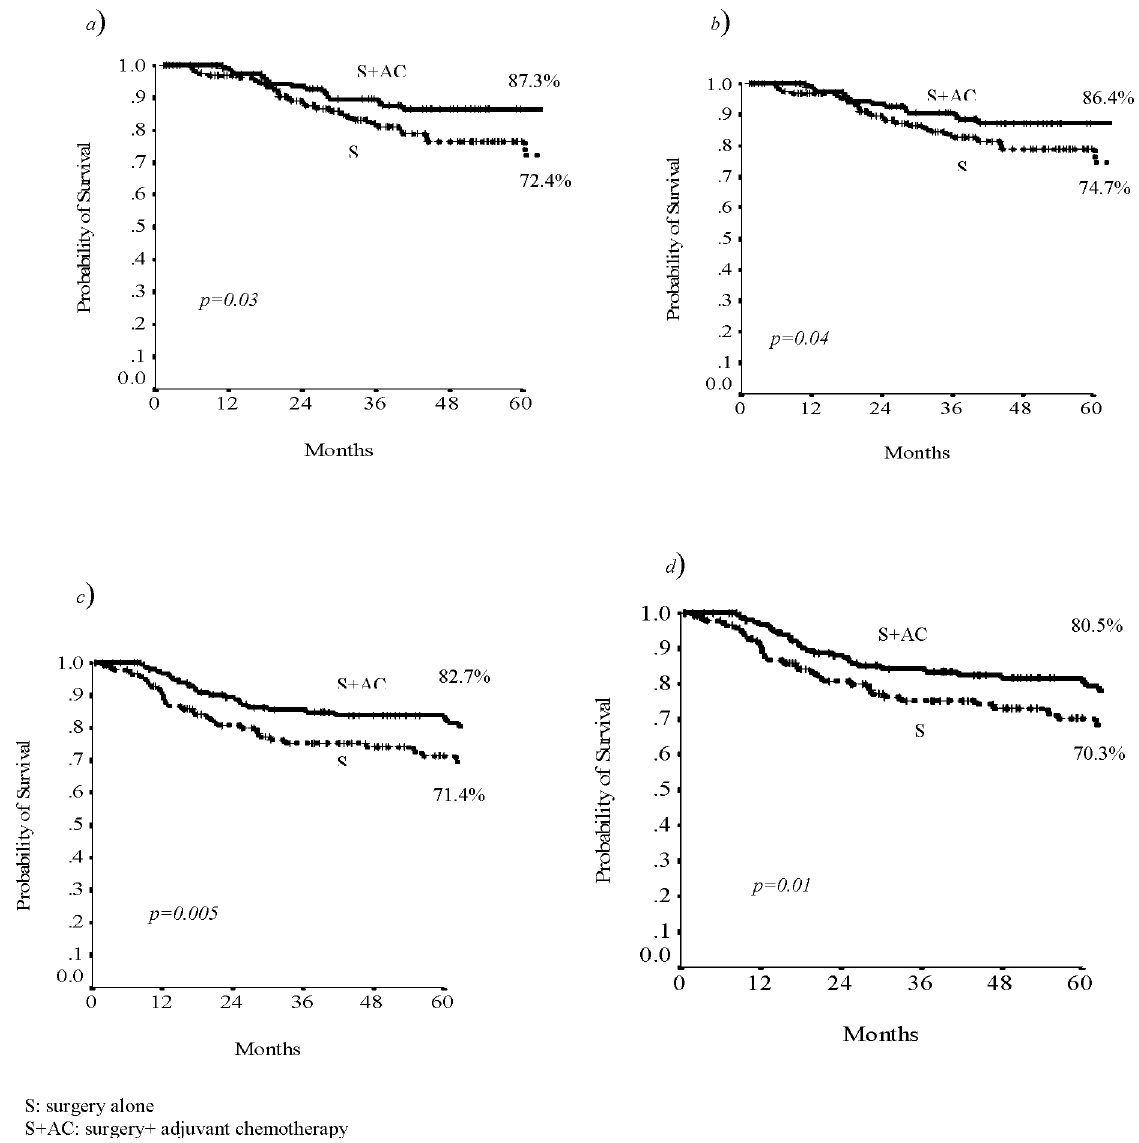
Figure 2. The 5-years RFS and DFS related to treatment in low risk group (a,b) and in high risk group (c,d).